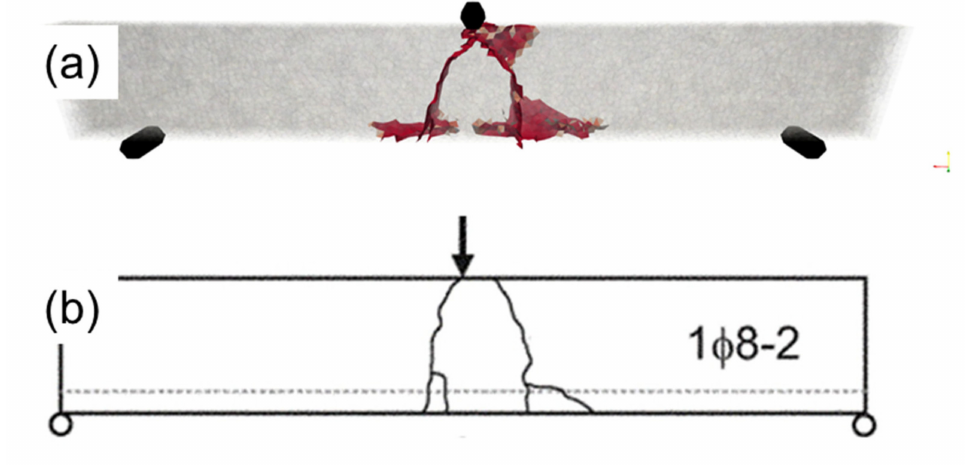
Figure 13. Crack patterns as a result of ( a ) the numerical simulation and ( b ) experiment (This figure has been reproduced from [34] with permission from American Concrete